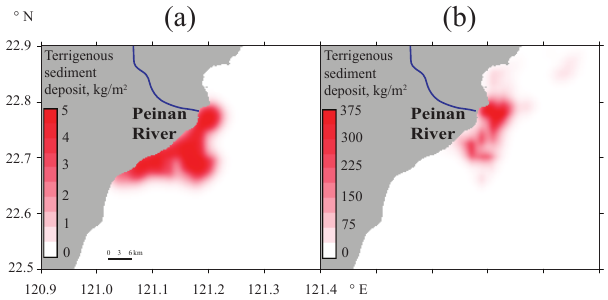
Figure 8. Simulated distribution of fine sediments deposited to the seabed in the study area under moderate (a) and flooding (b) forcing